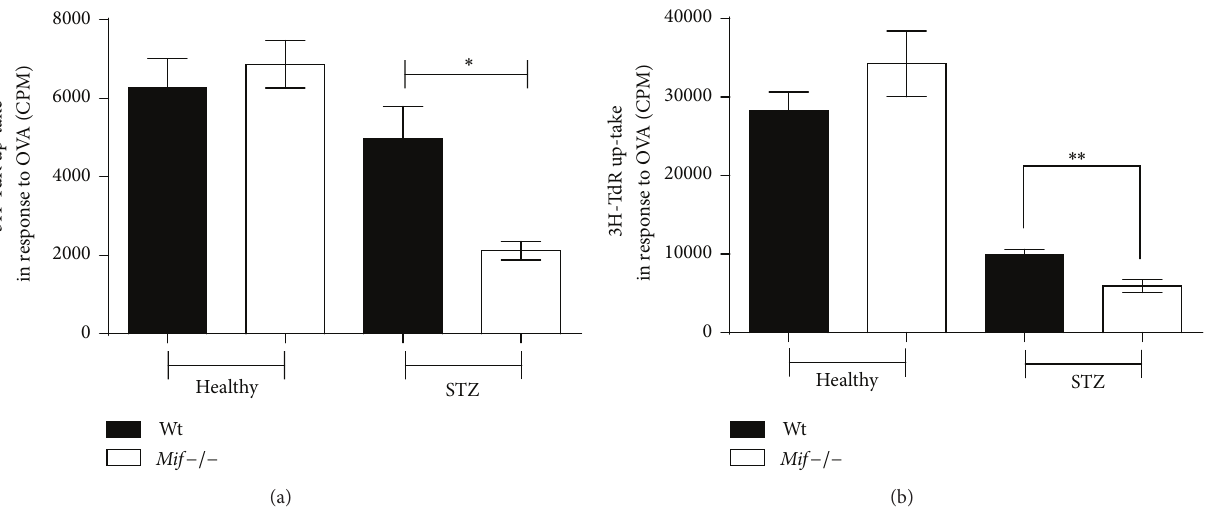
Figure 9: Macrophages and monocytes from Mif − / − mice have impaired ability to induce lymphocyte proliferation. At 8 weeks after STZ treatment, Wt ( ◼ ) or Mif − / − ( ◻ ) M 𝜑 (F4/80 + ) and monocytes (CD11b + ) primed with 10 𝜇 g/mL OVA were cocultured with OVA-transgenic T cells for 5 days. Subsequently, [3H]-thymidine was added for 18h, and [3H]-thymidine incorporation was measured. The values are presented as means ± SEM counts per minute (CPM) from triplicate wells of three independent experiments ( 𝑛 = 8 ). ∗ 𝑝 < 0.05 or ∗∗ 𝑝 < 0.01 . GraphPad Prism software 6, GraphPad Prism software